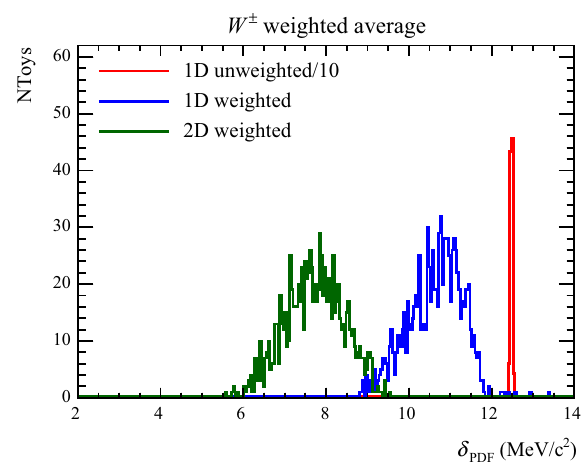
Fig. 13 The distribution of the PDF uncertainty evaluated for 1000 toy datasets from (left) a simultaneous fit where the W + and W − templates share the same normalisation or (right) a weighted average of single W charges measurements. Three different fit methods are compared: p